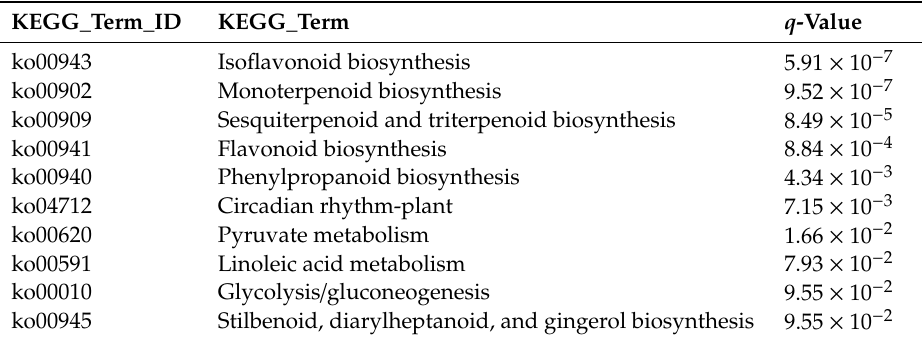
Table 3. Enriched KEGG pathways in